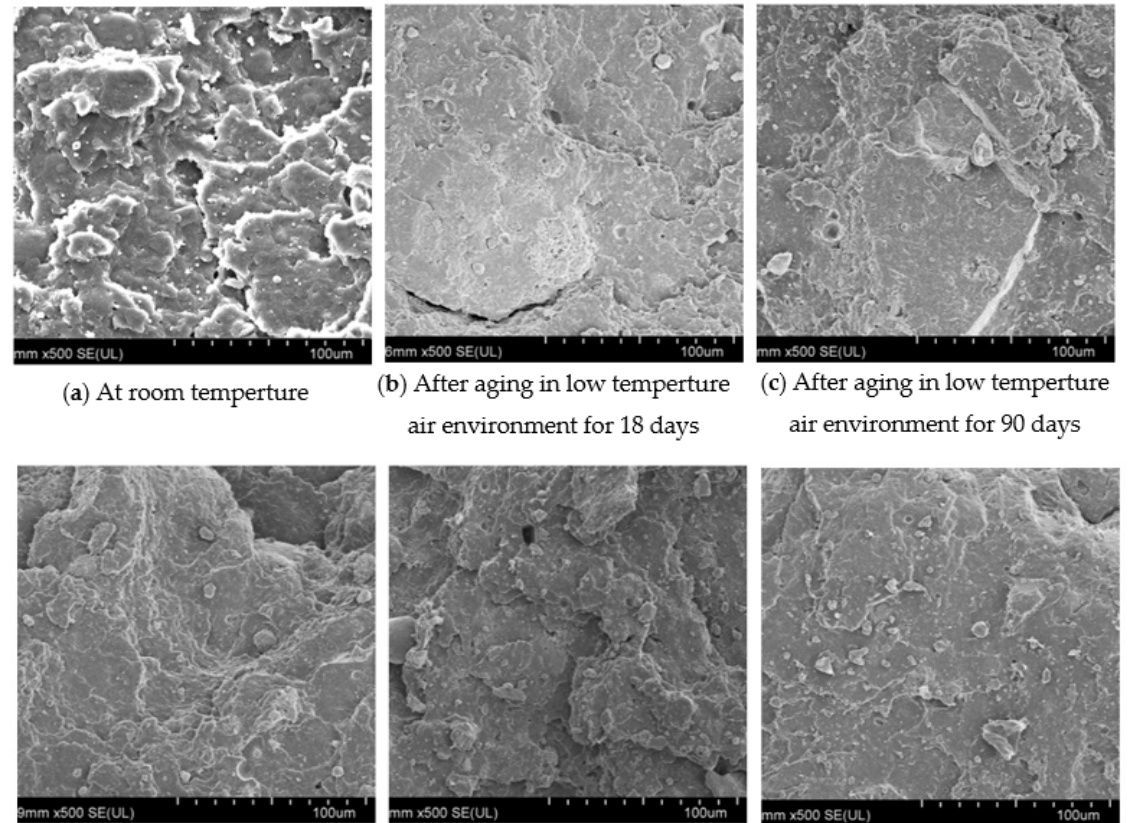
Figure 8. Micromorphology of section.